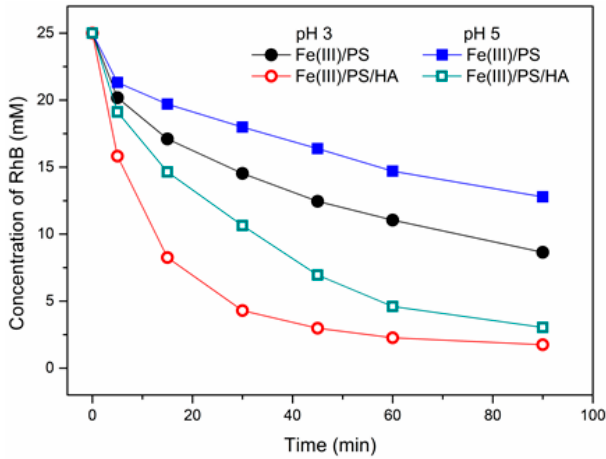
Figure 5. Effect of Fe(III) on RhB degradation under various pH conditions. Homogeneous catalytic degradation of RhB at initial pH 3 and 5. Concentrations: [Fe(III)] = 25 µM, [RhB] = 25 mM, [PS] = 5 mM, and [HA] = 0.5 mM.